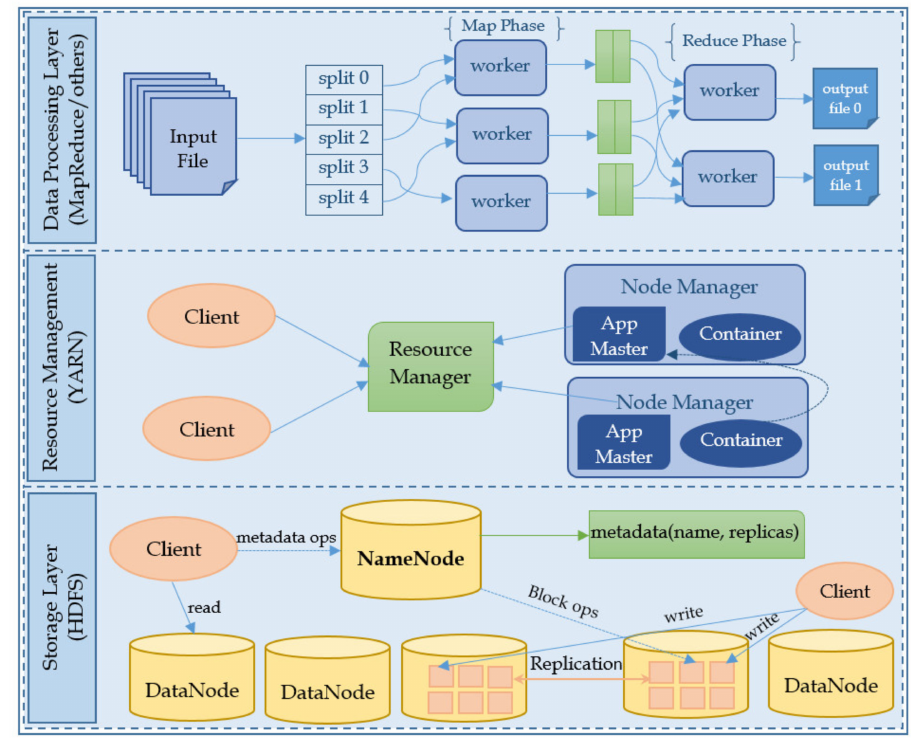
Figure 5. Apache Hadoop